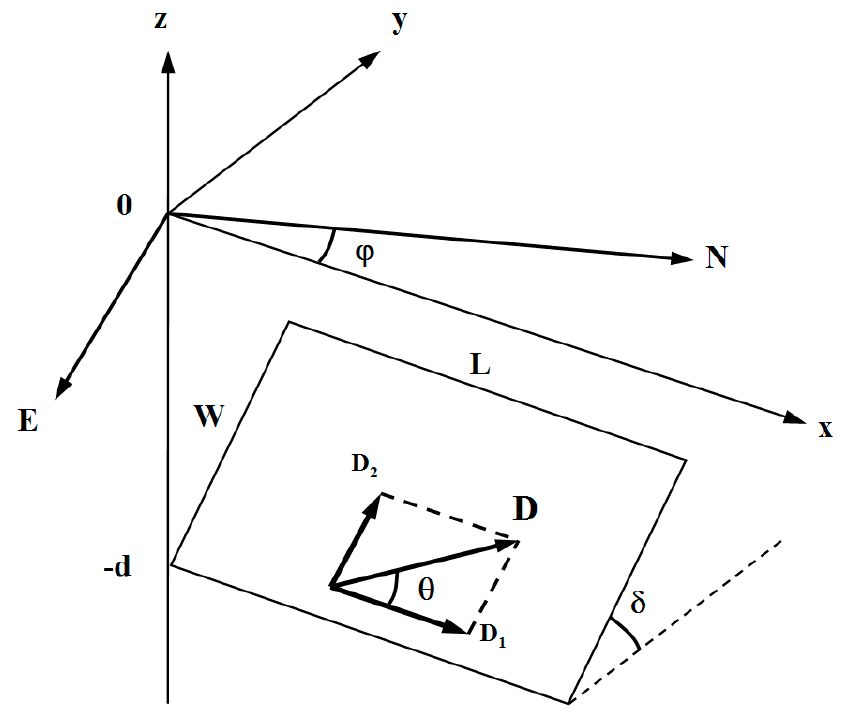
Figure 2. Geometry of the source model.